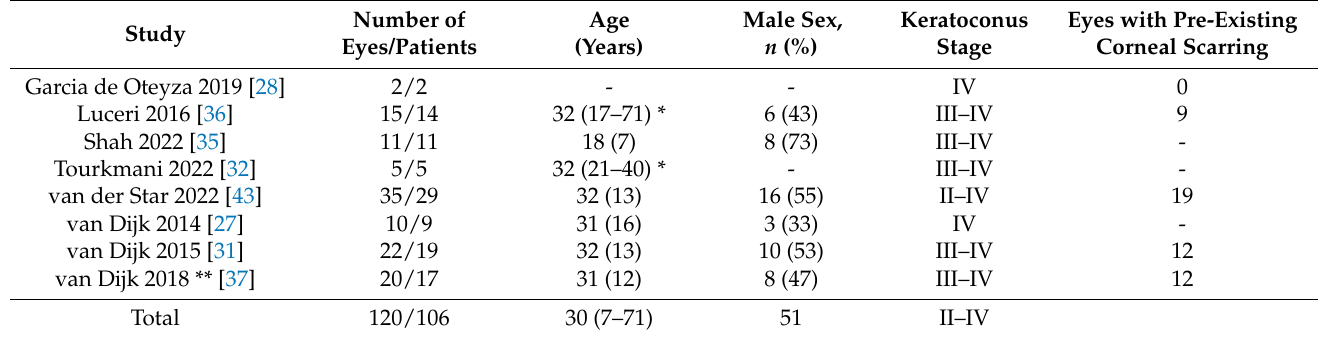
Table 3. Baseline characteristics of the study population.